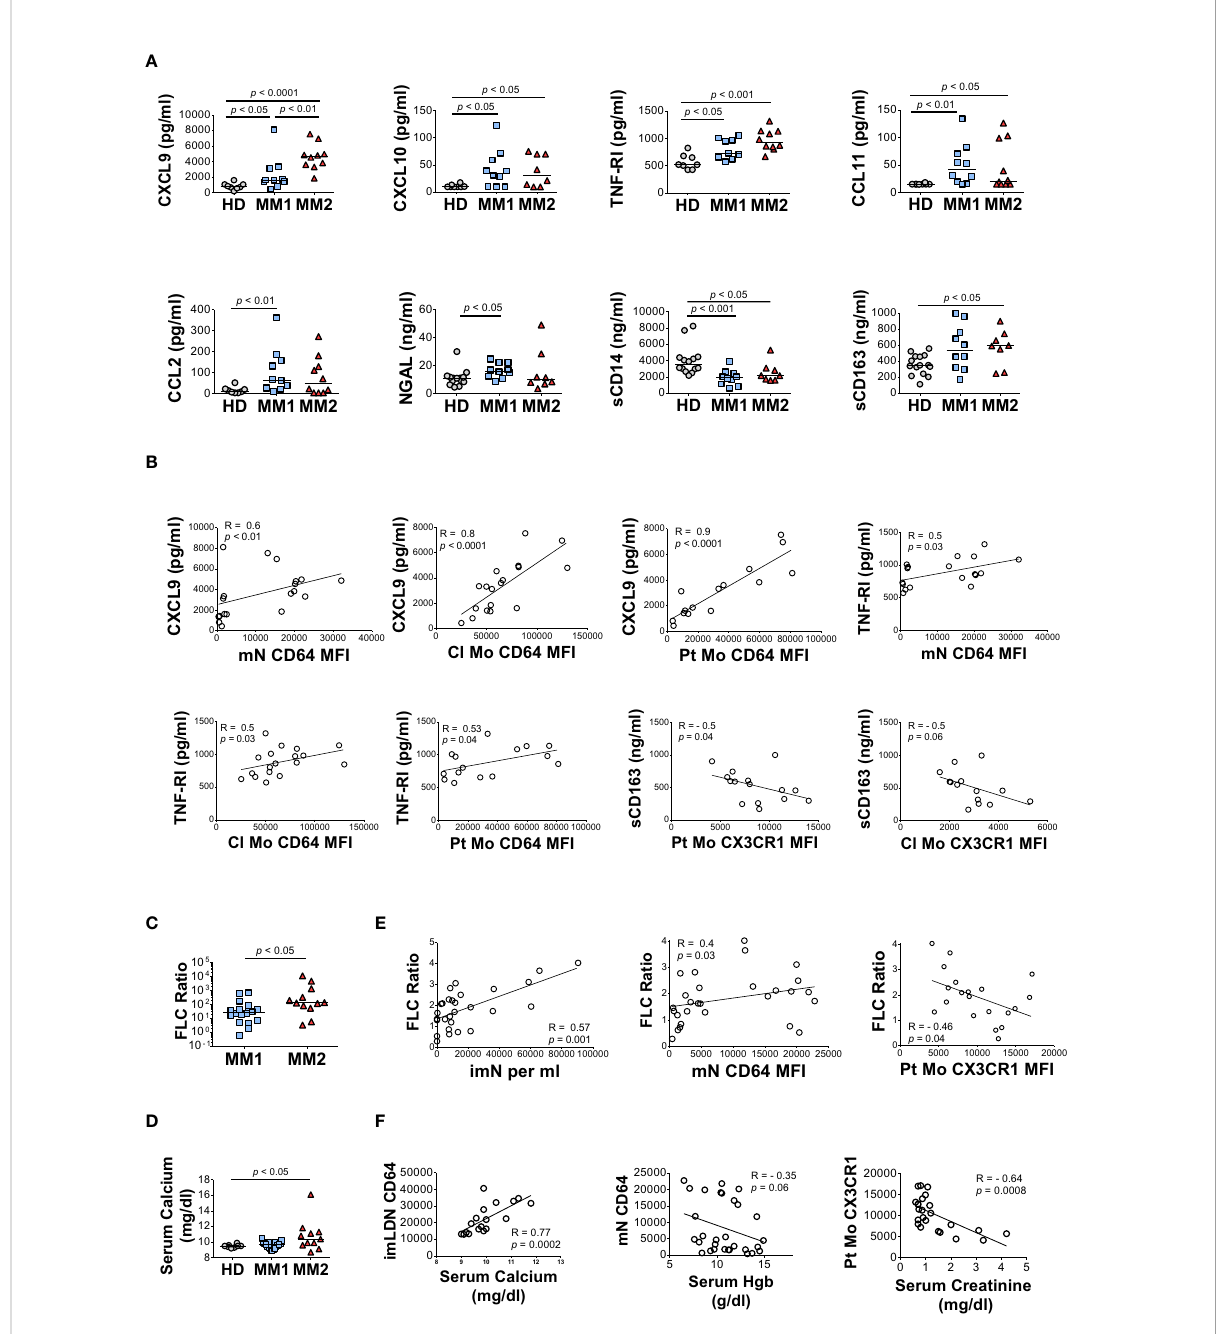
FIGURE 5 The MM2 phenotype is associated with changes in the plasma levels of markers of in fl ammation and with clinical markers of disease progression. (A) Levels of cytokines and markers of myeloid activation in plasma of HD and MM1 and MM2 patients. (B) Correlations between the plasma levels of markers of myeloid activation and surface levels of antigens on mN and patrolling monocytes. (C) (involved/uninvolved immunoglobulin free light chain) FLC Ratio of MM1 and MM2 patients. (D) Serum calcium levels of HD, MM1, and MM2 patients. (E) Correlation between the FLC ratio and characteristic features of the MM2 phenotype ( n =29). (F) Correlations between the characteristic features of the MM2 phenotype and myeloma-de fi ning events ( n =24). Serum calcium levels adjusted for albumin [(0.8 x (4g/dl*normal albumin – patient albumin)) + patient serum calcium level]. MFI, median fl uorescent intensity. (A, C, D) or the Spearman correlation test (B, E, F) . Spearman correlation coef fi cients R and p values are indicated; bars and lines represent median values and simple linear regression analysis,